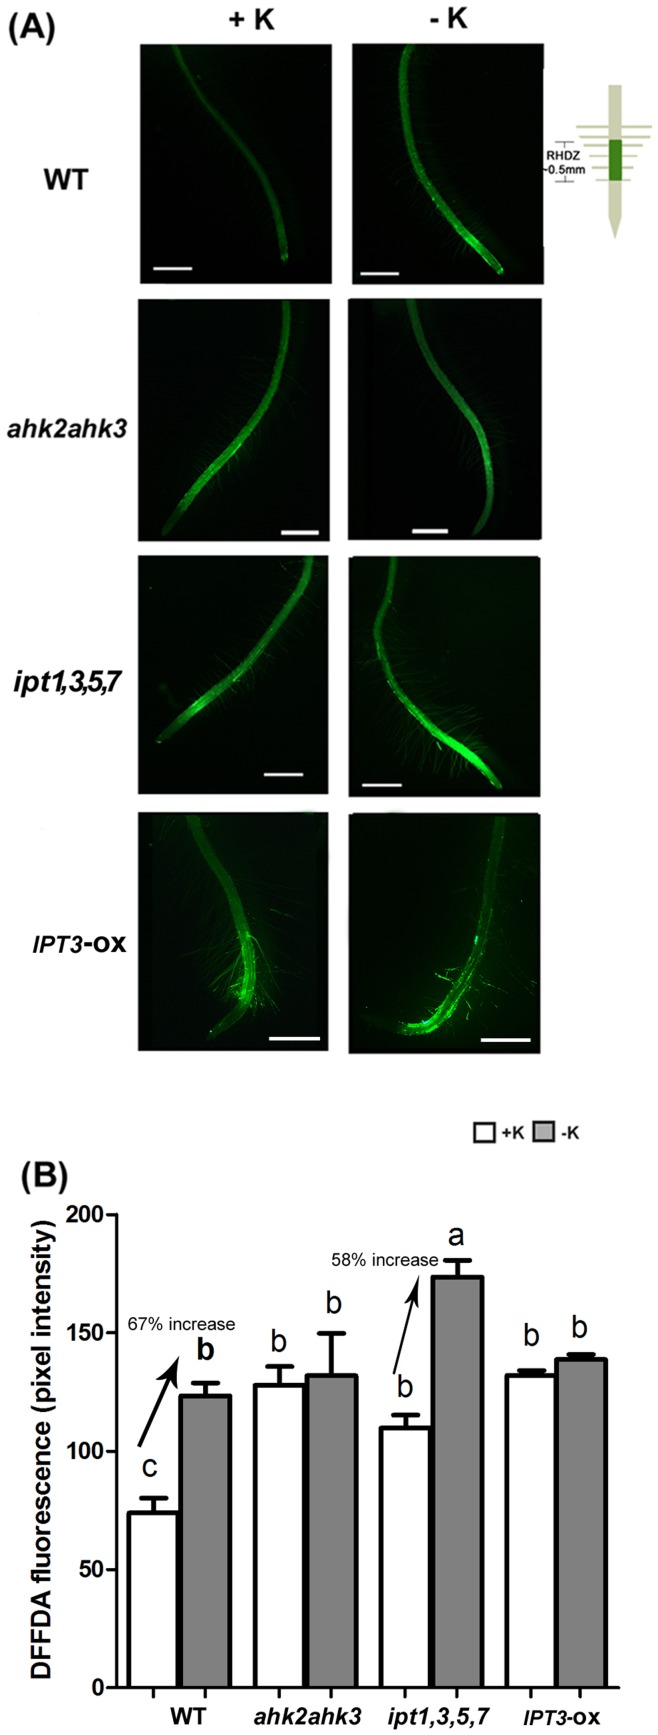
Low K-dependent ROS accumulation was obstructed in ahk2ahk3 mutant and enhanced in ipt1,3,5,7 mutant.(A) Pseudo-colored ROS fluorescence signals were detected in WT, ahk2ahk3 and ipt1,3,5,7 roots after staining with 20 µM of DFFDA for 20 min. Bar indicates 0.5 mm. (B) Quantification of DFFDA fluorescence signal shown in Figure 4A. Pixel intensity of the roots was measured from the root hair differentiation zone to 0.5 mm. Different letters indicate significant differences from each other as determined using ANOVA (P<0.05) and significances were corrected post hoc using Tukey’s HSD comparisons. (n>20).